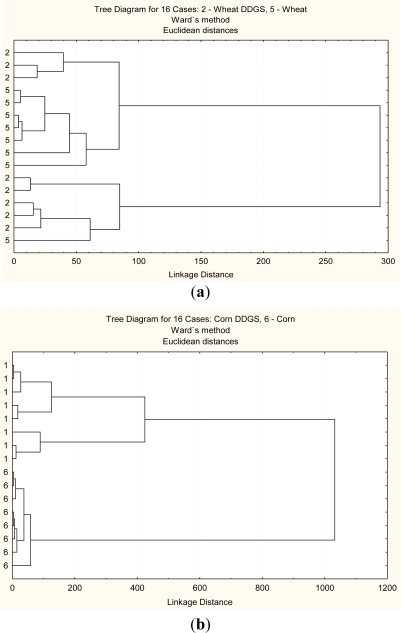
Multivariate molecular spectral analyses of the co-products from bioethanol production at the whole mid-infrared region (4000–827 cm−1): CLA cluster analyses of molecular spectrum (Region ca. 4000–827 cm−1; Distance method: Euclidean; Cluster method: Ward’s algorithm); (a) wheat DDGS (code 2) vs. wheat (code 5); (b) corn DDGS (code 1) vs. corn (code 6).